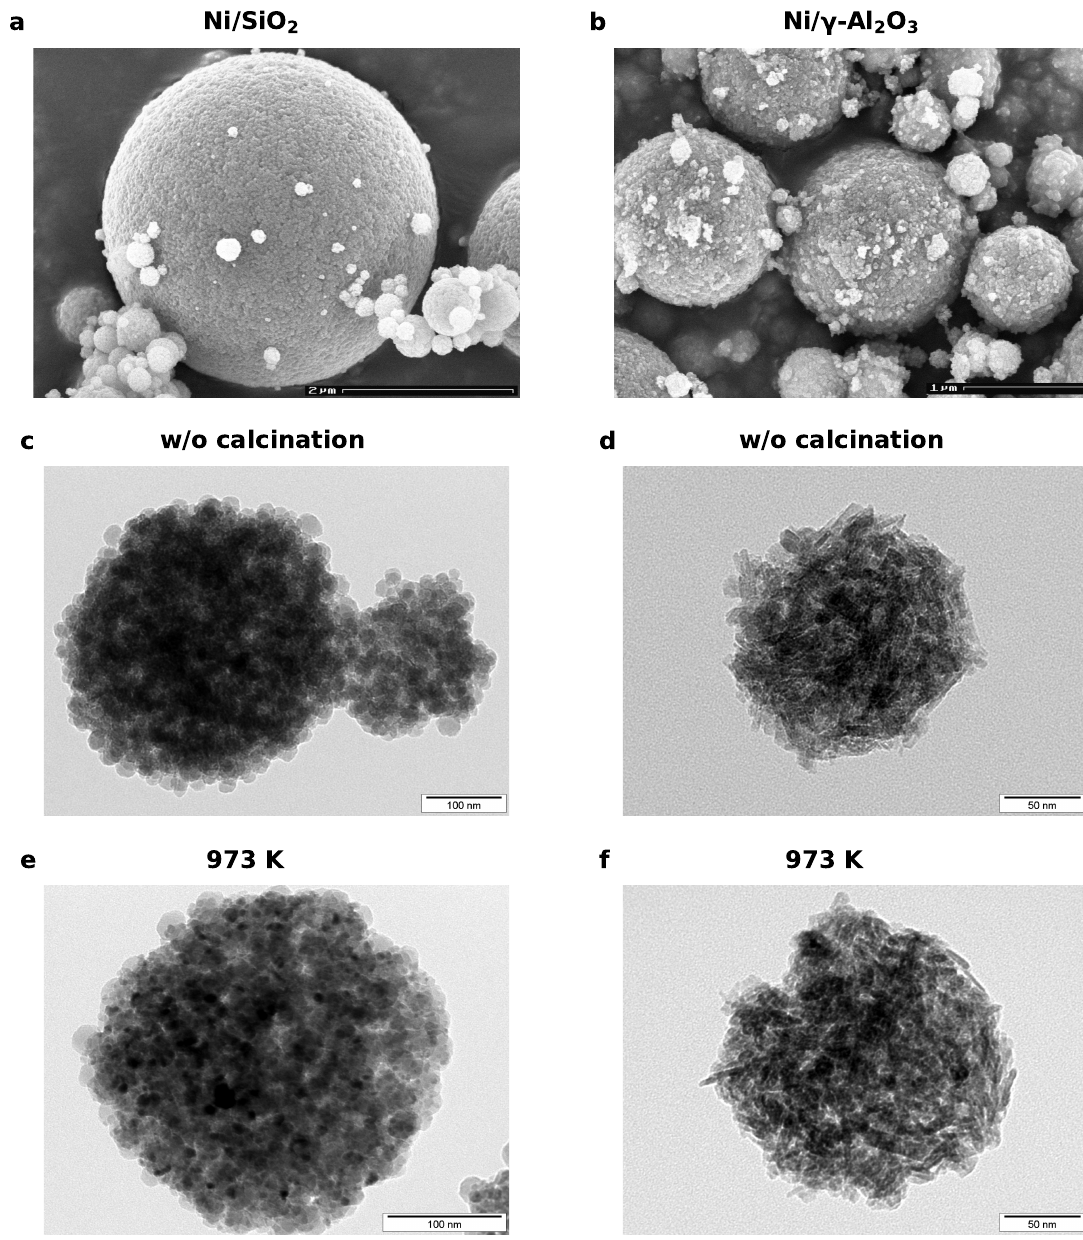
Figure 2. SEM images of the ( a ) BB(20) and ( b ) BB(Al 2 O 3 ) with a Ni loading of 20wt%. TEM micrographs of ( c ) BB(20) and BB(Al 2 O 3 ) ( d ) after production (without (w/o) calcination). ( e ) BB(20) and ( f ) BB(Al 2 O 3 ) after calcination at 973K for